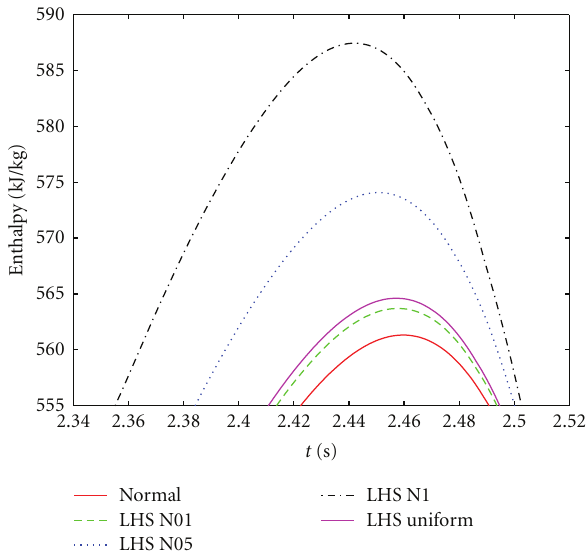
Figure 15: Enthalpy upper tolerance limit (UTL) for LHS sampling method.